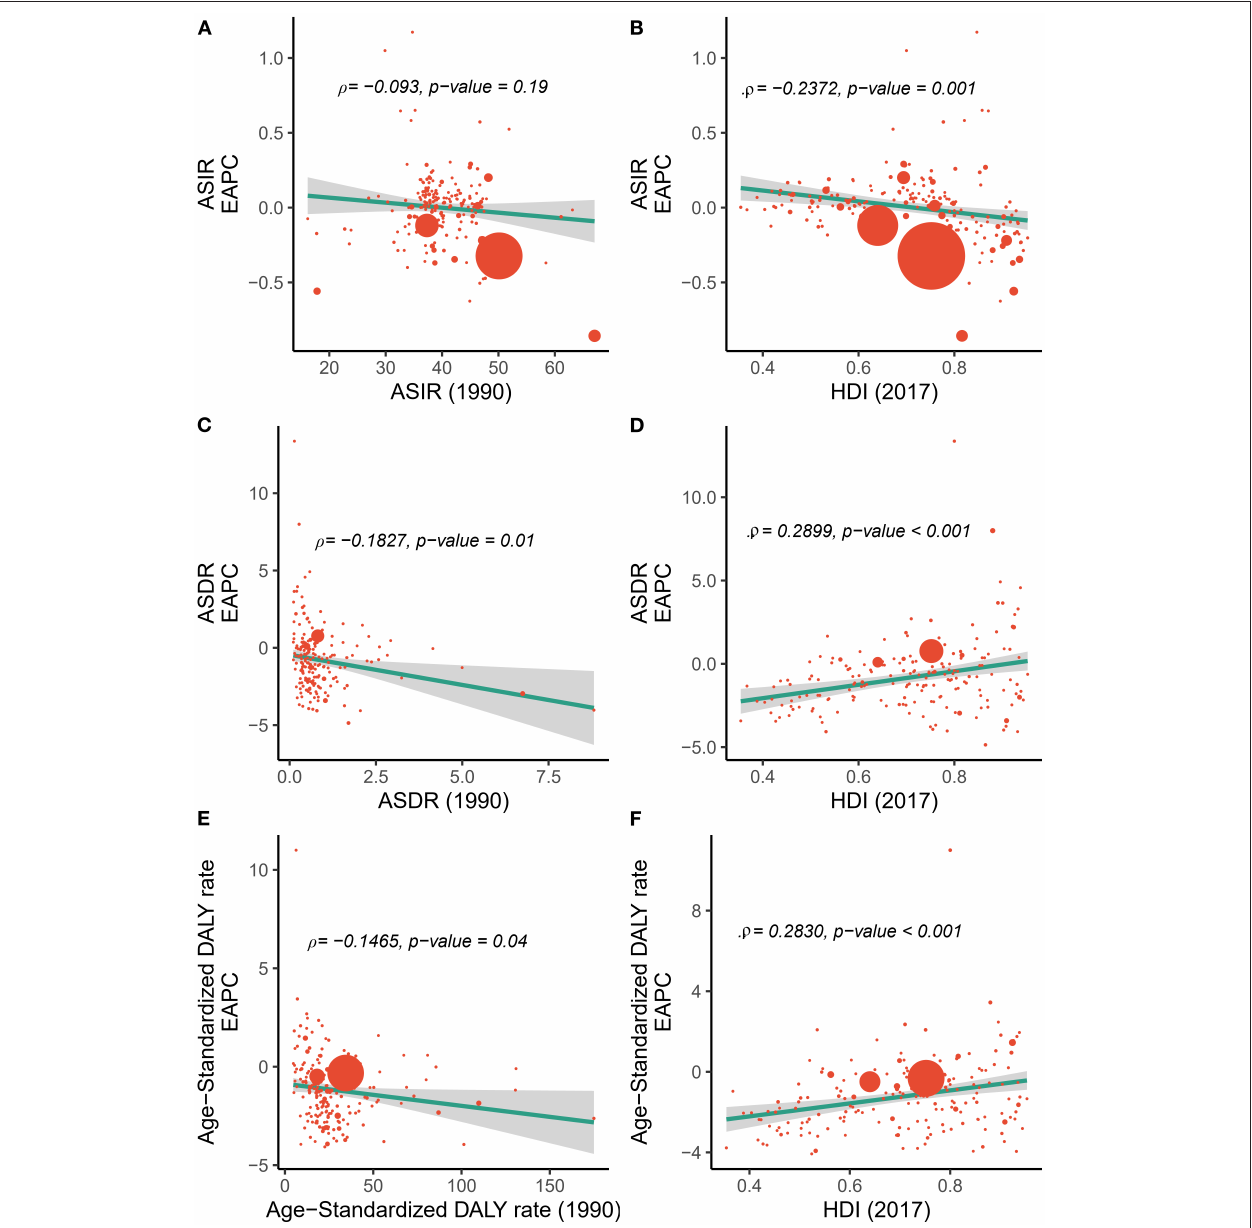
(95% UI = 39,710–51,820) in 2017. However, the global